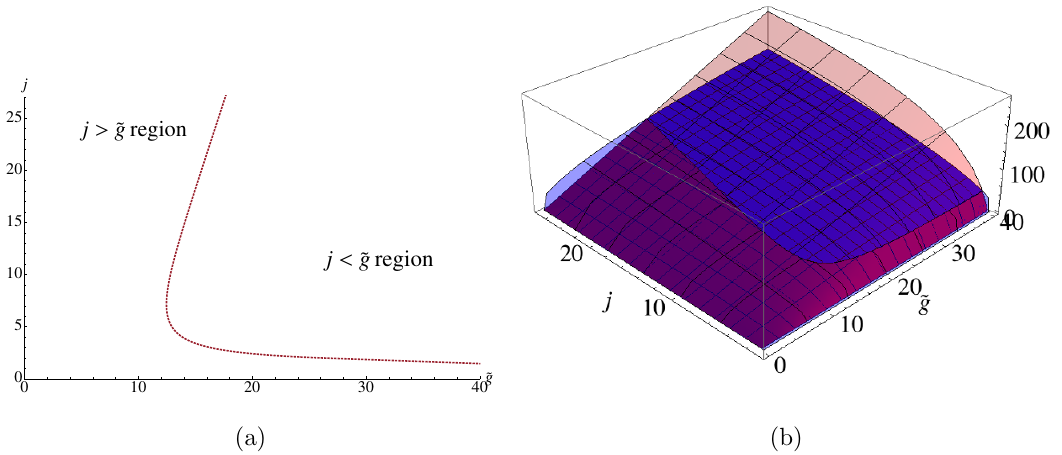
Figure 3. (a) Real solutions of the equation (cid:0) ( G 6 = 5 ) cusp log( j ) (cid:0) G = 0, showing the intersection 8 = 7 curve between the two functions. (b) Relevant parts of the surfaces (cid:0) ( G 6 = 5 ) cusp log( j ) (red solid and transparent surface) and G (blue solid and transparent surface) plotted together. Dominant 8 = 7 branches are in transparent colour while subdominant ones are in solid colour. The transition line has the distinctive shape we got from the analytical solution and the total surface represents the anomalous dimension over the ~ g (cid:0) j